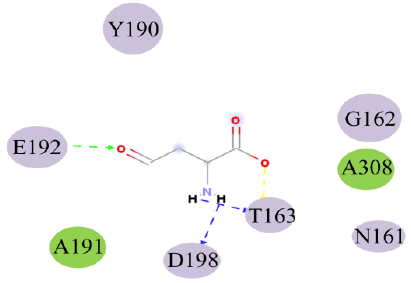
Figure 6. Active residues in the ASA binding pocket. The color purple represents strong van der Waals (VDW) contact with ASA, and the color green represents electronic contact with ASA.